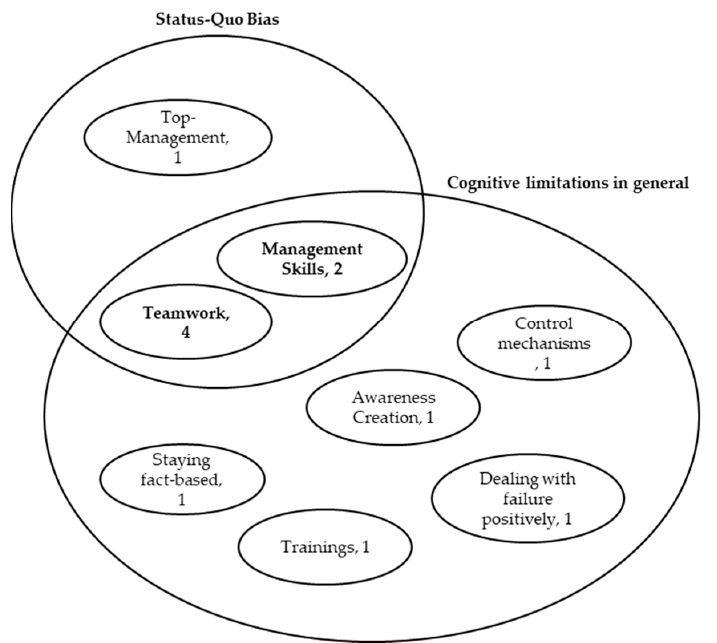
Figure 6. Interview partners response on countermeasures to overcome the status quo bias and cognitive limitations in general, number indicates quantity.